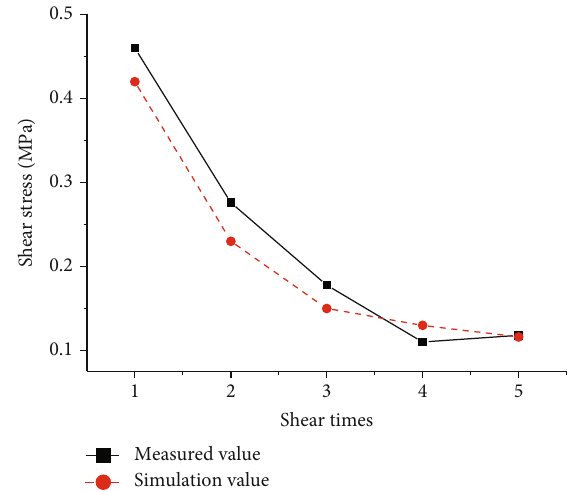
Figure 14: Experimental and simulated results for the peak value of shear